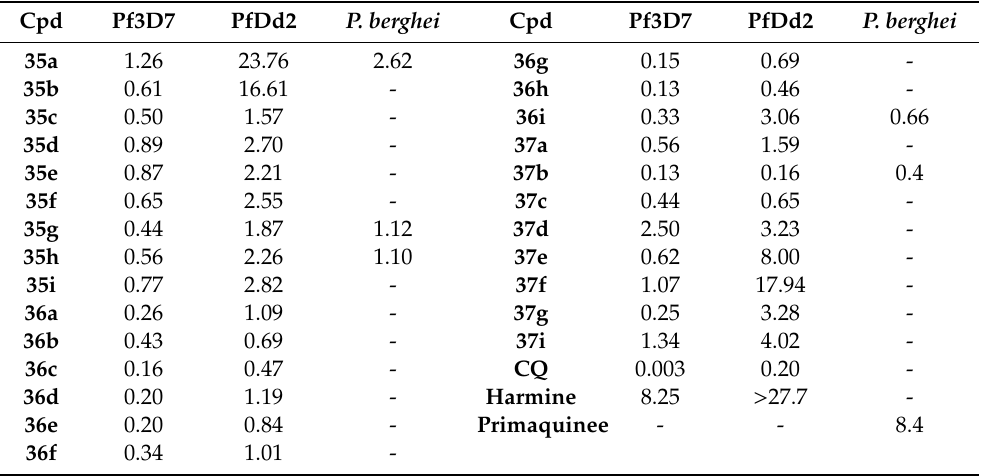
Table 8. IC 50 ( µ M) values for compounds 35 – 37 after in vitro screening against erythrocytic stage of P. falciparum (Pf3D7 and PfDd2 strains) and hepatic stages of P. berghei [33].